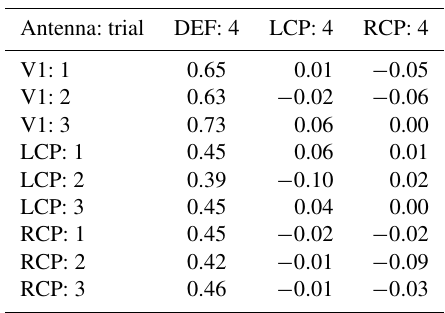
Table 11. Mean values of the imaginary part of the complex cor- relation coefficients over frequency for different antenna pairs. The Roman numerals indicate from which measurement trial the mea- sured sample sequences of the specified antenna